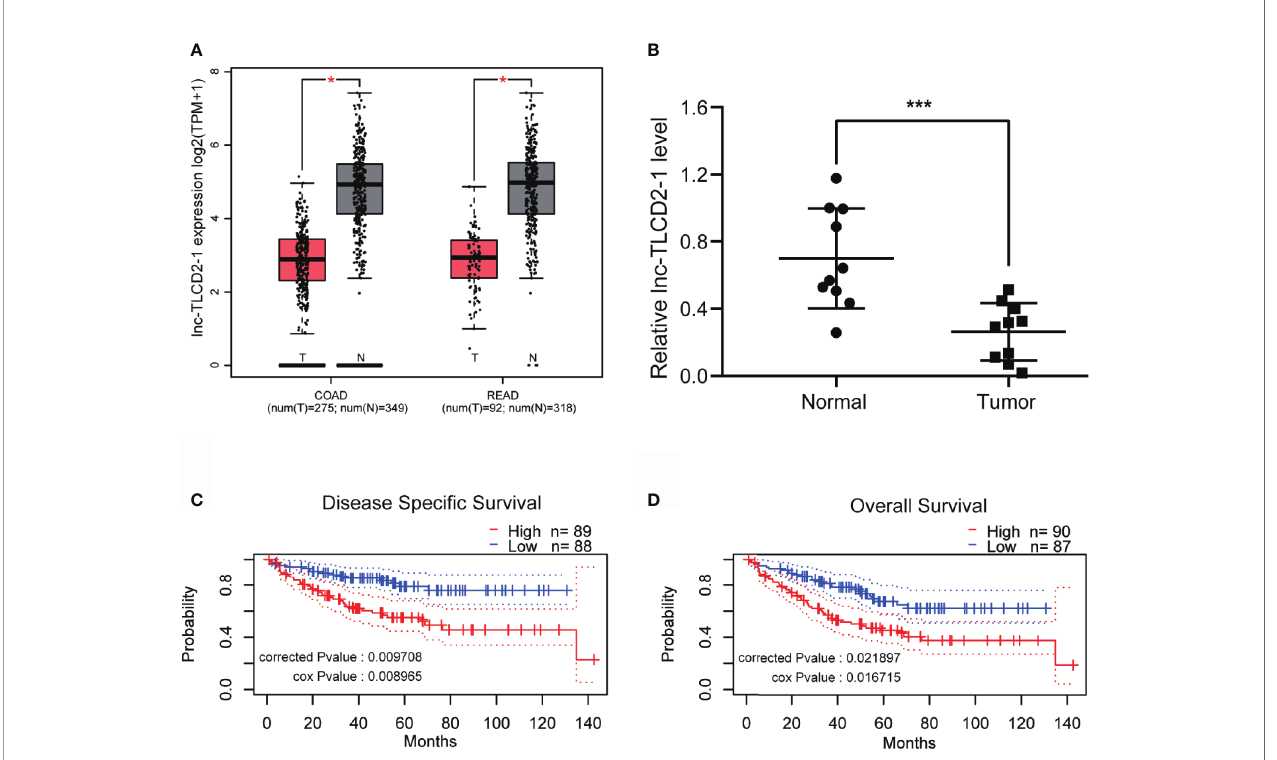
FIGURE 2 | The expression of lnc-TLCD2-1 is generally low in CRC, and the high expression of it predicts a short survival. (A) TCGA database revealed low expression of lnc-TLCD2-1 in colorectal cancer (COAD stands for colon cancer, READ stands for rectal cancer). (B) The low expression of lnc-TLCD2-1 in CRC tissues were veri fi ed in 10 paired samples by qRT-PCR. (C, D) Disease Speci fi c Survival and Overall survival analysis results were obtained from GSE17536 dataset, high expression of lnc-TLCD2-1 predicts a short survival. (P<=0.05 means statistically signi fi cant, *p < 0.05, ***p <